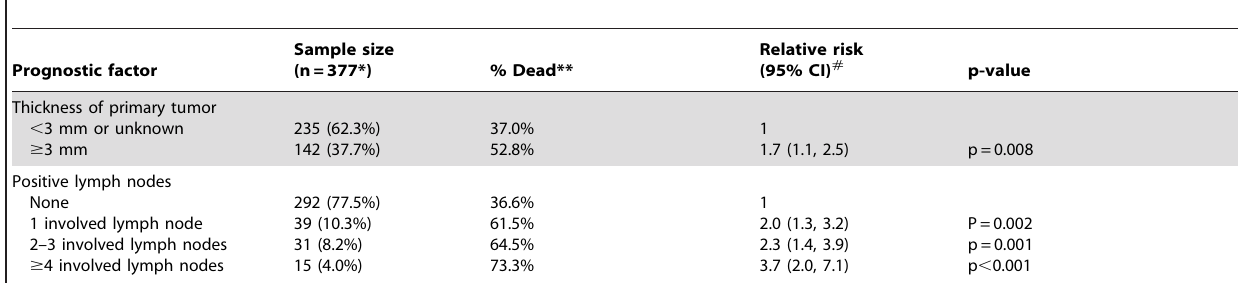
Table 2. Independent prognostic factors for 377 patients with satellite or in-transit metastases according to the multivariable Cox proportional hazard